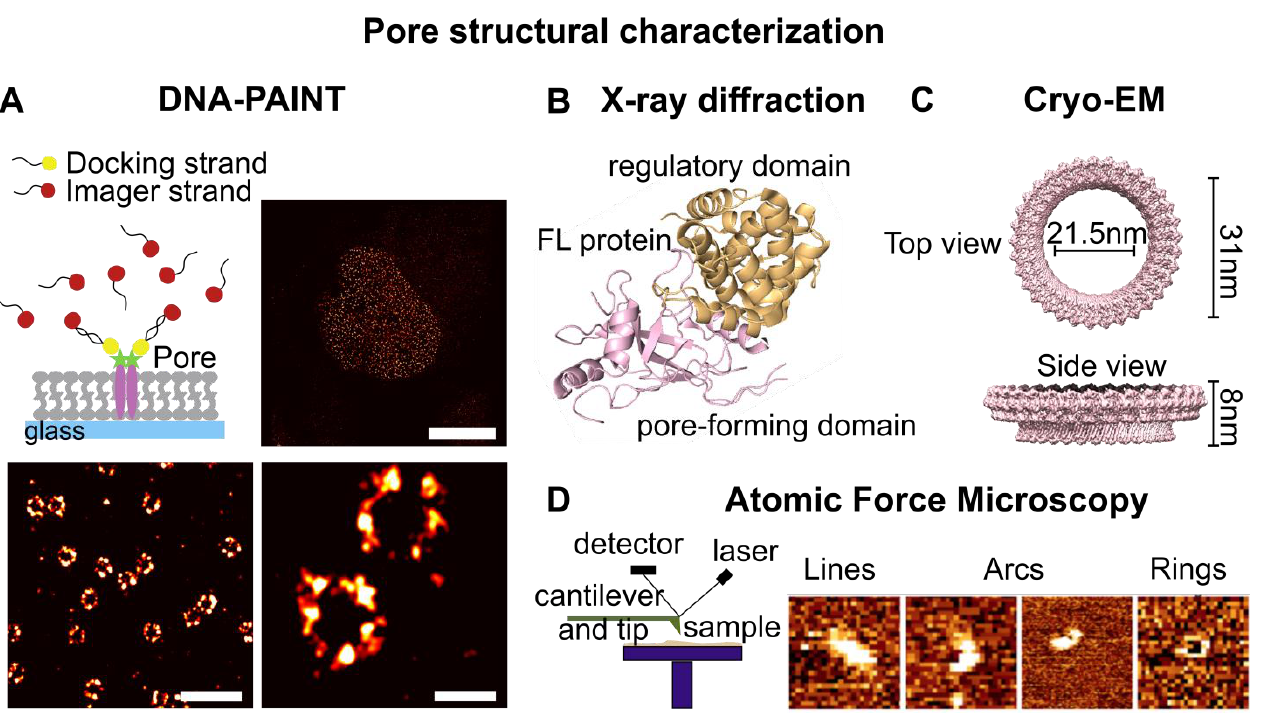
Figure 4. Techniques for the structural characterization of membrane pores. ( A ) DNA-PAINT schematic representation and analysis of the nuclear pore complex revealing the ring-shaped structure of the pores. Scale bars: 10 µm for the overview ( top right ), 500 nm ( bottom left ), and 100 nm ( bottom right ) for the zoomed-in images. ( B , C ) X-ray crystallography and cryo-electron microscopy allow for determining the structure of a protein at atomic resolution. ( B ) Crystal structure of FL GSDMD obtained via X-ray diffraction (pdb: 6N9O). ( C ) Top and side views of GSDMD pore structure obtained via cryo-EM revealing a full pore of 33 subunits (pdb: 6VFE). ( D ) Atomic force microscopy schematic representation ( left ) and AFM images of Bax structures on model membranes (picture size 100 nm) ( right , adapted from [54]).